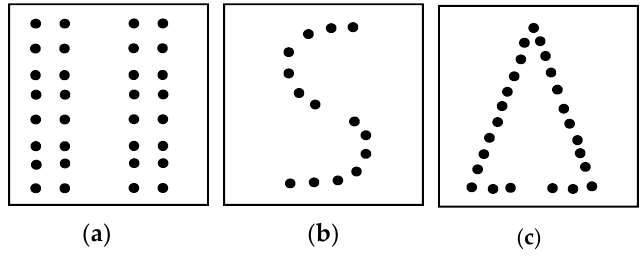
Figure 5. Grouping principles with regards to: ( a ) proximity; ( b ) continuity; and ( c ) closure.